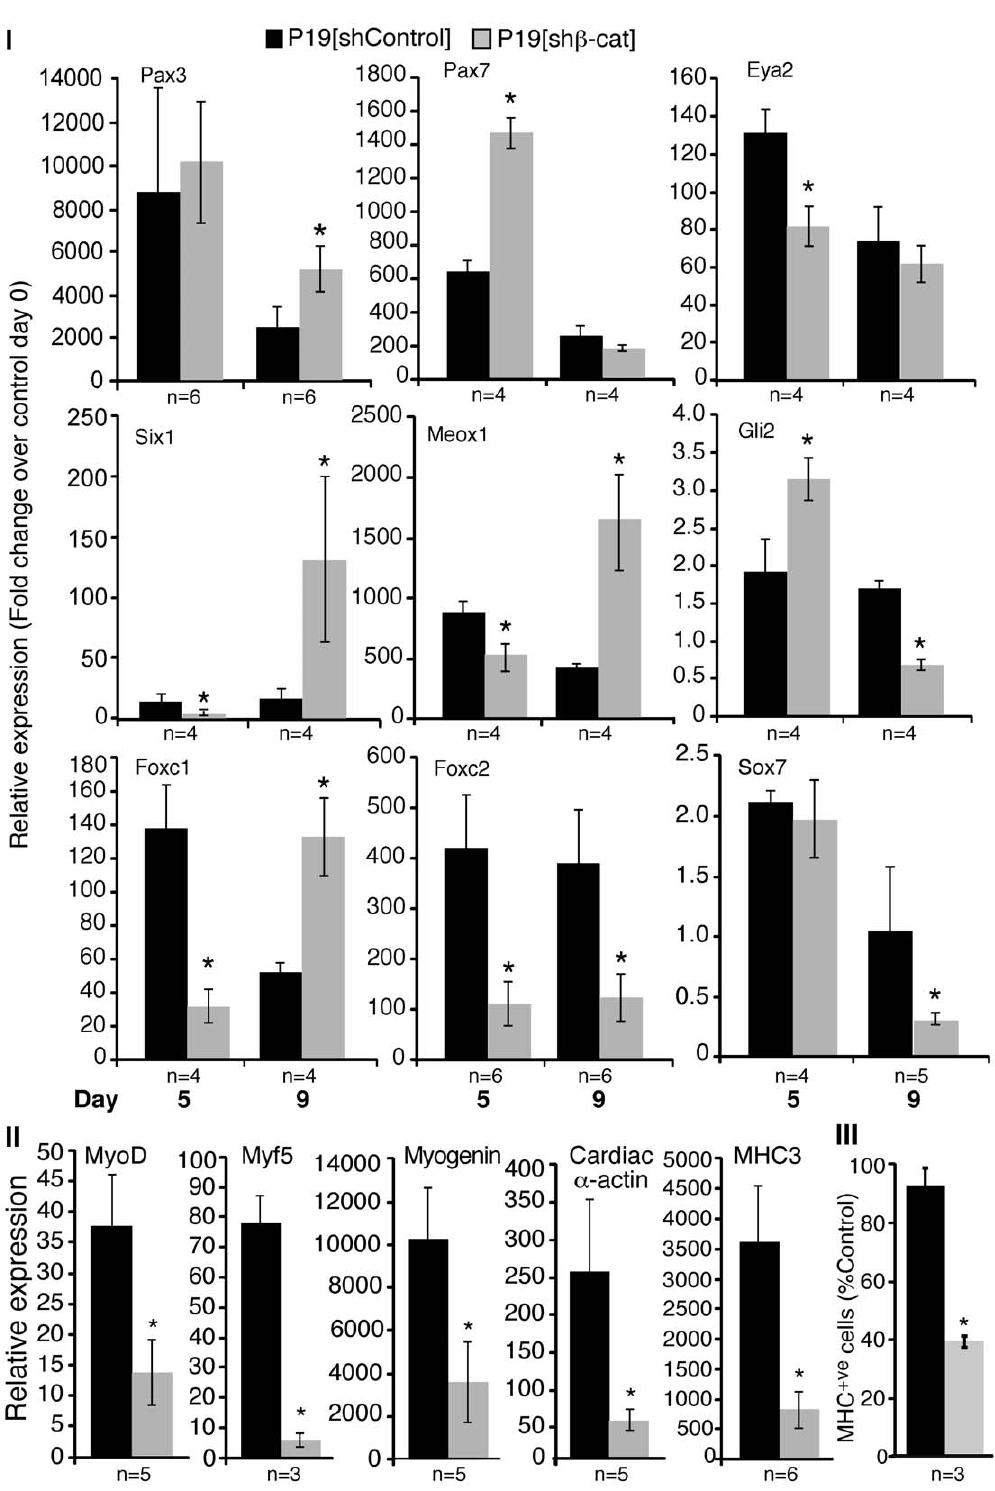
Figure 5. RA can recover the expression of most skeletal muscle precursor genes in P19[sh b -cat] cells. Aggregated P19[shControl] and P19[sh b -cat] cells were differentiated in the presence of 1% DMSO with 3 nM RA. Panels I & II: RNA was harvested on days 0, 5 and 9 of the differentiation and analyzed by QPCR for all days (Panel I) or days 0 & 9 (Panel II). Changes in gene expression were normalized against b -actin represent fold change over day 0 levels in P19[shControl] cells. Error bars correspond to the 6 SEM. Panel III: Cultures were fixed on day 9 for immunofluorescence with an anti-MHC antibody. The number of MHC + ve cells were counted and expressed as a percentage of the control cells. Error bars represent 6 SEM (n=6). The Student’s t-test was used to assess statistical significance, where *p-value # 0.05.